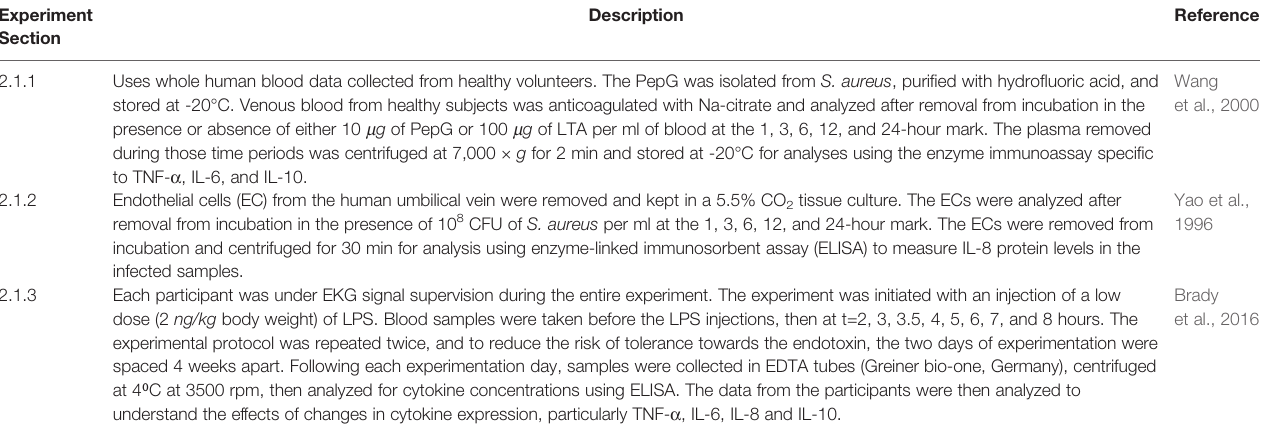
TABLE 1 | Experimental data used in the formulation and validation of the mathematical